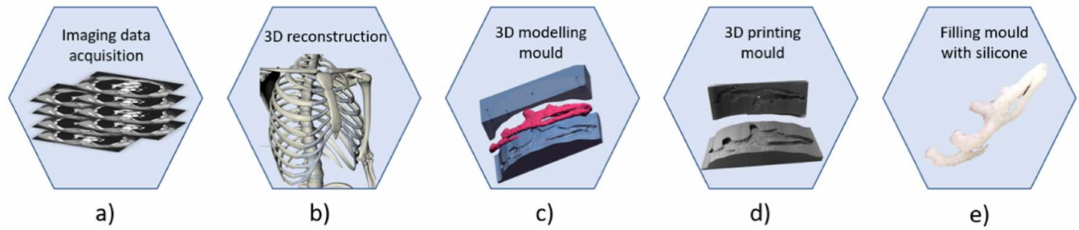
Figure 4. Workflow to produce an accurate replica of costal cartilage: a ) image data acquisition of the thoracic region through with CT scan; b ) image processing and 3D reconstruction of ROI (Region Of Interest); c ) modelling of mold with 3D modelling software; d ) printing of the mold; e ) pouring silicone rubbers inside the mold.